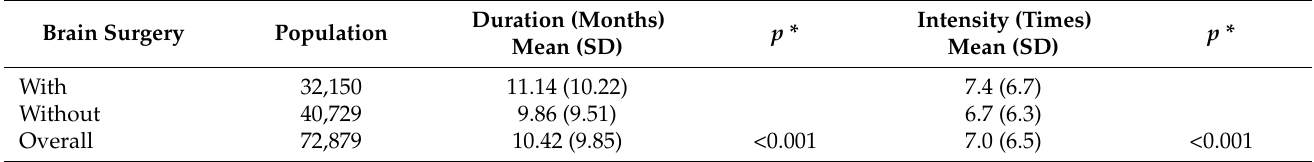
Table 6. Duration (months) and intensity (times) of OT/PT within one year of TBI